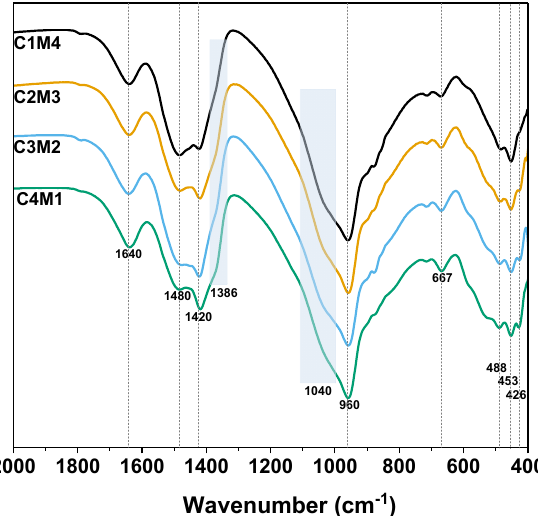
Figure 9. FTIR spectra of the Na 2 CO 3 –activated slag binders modified with Ca(OH) 2 and Mg(OH) 2 .